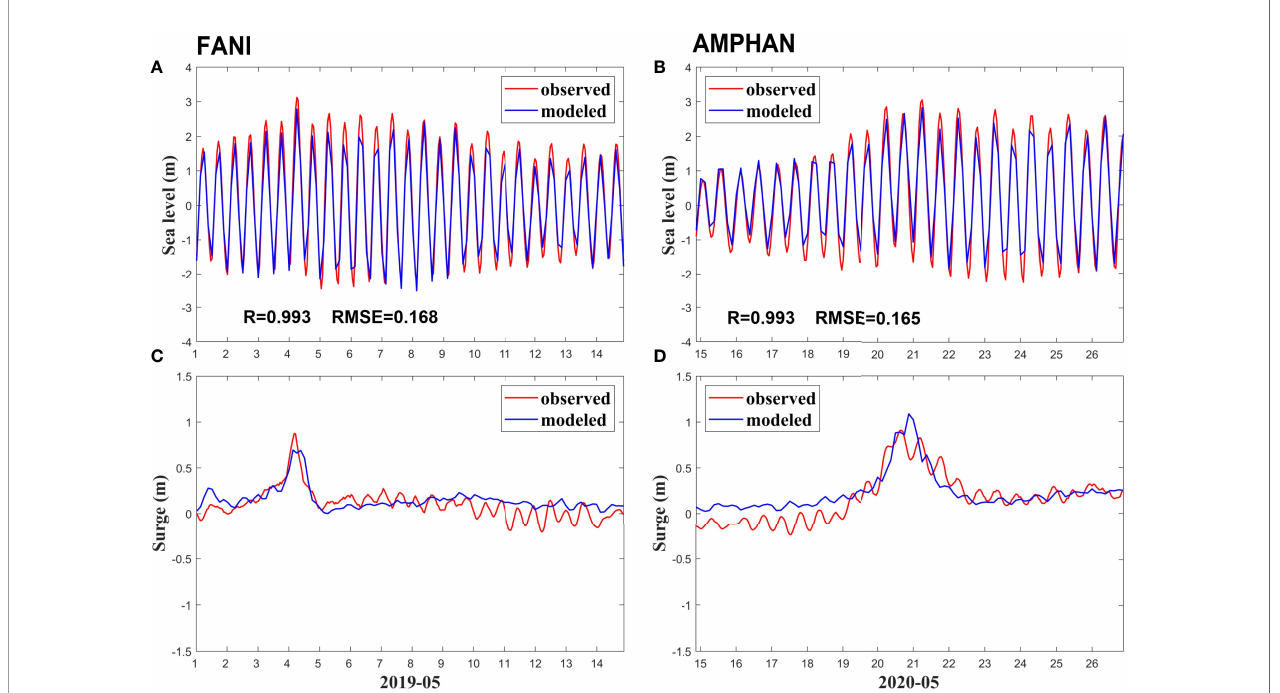
TABLE 3 | The RMSE and MAB of the minimum sea-level pressure (MSLP, unit: hPa) and maximum wind speed (MWS, unit: knots) for the 8 tropical cyclones in the NIO during 2018 – 2020. Forecast time RMSE of MSLP MAB of MSLP NCEP-GFS